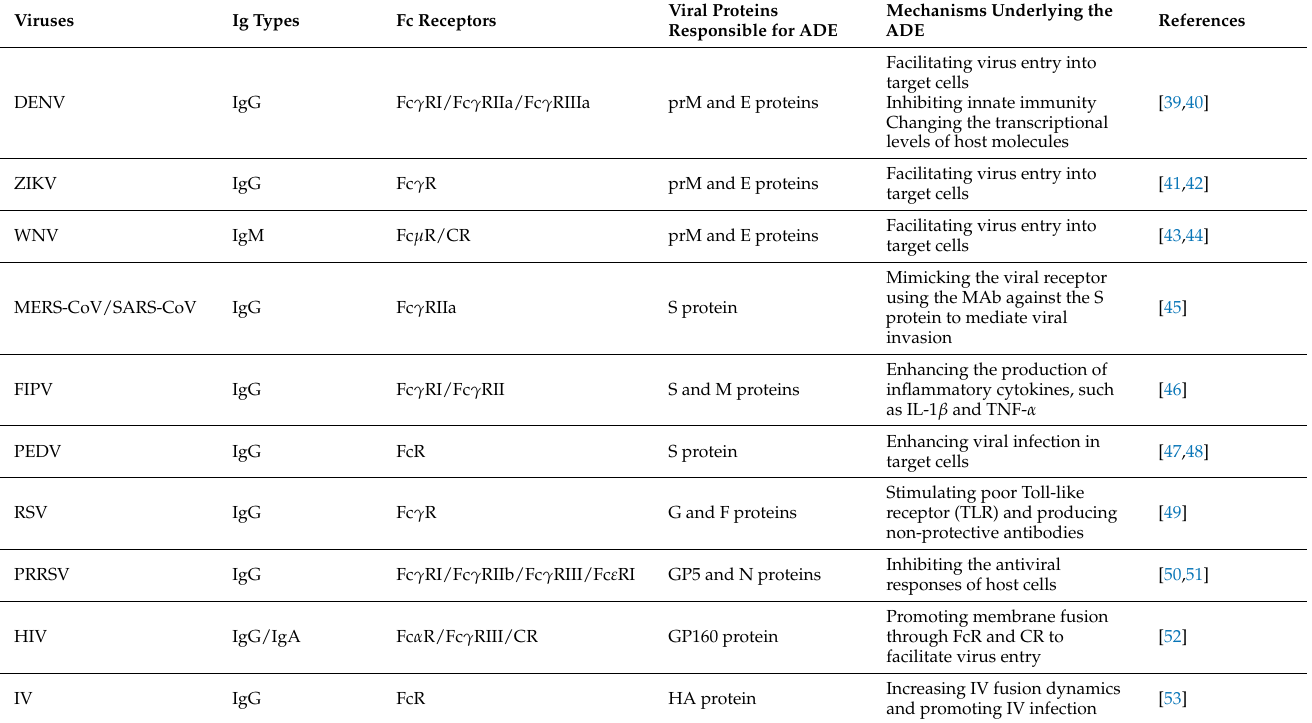
Table 1. The mechanisms underlying the ADE of viral